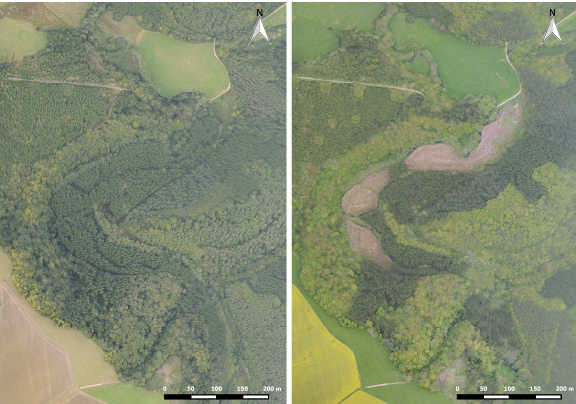
Figure 8. Generation of before and after orthomosaics for documentation purposes. Left: Man-made firs bar that divides two habitats of flora and fauna before clearing (September 2013). Right: Cleared area of the former firs bar (May 2014).